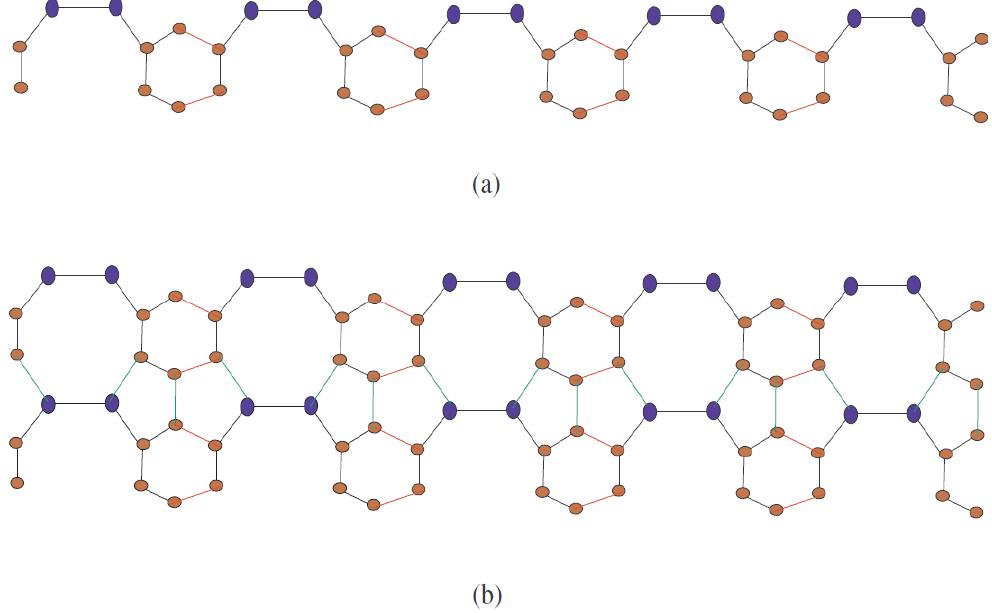
- III [ n,m ], (a) SiC 3